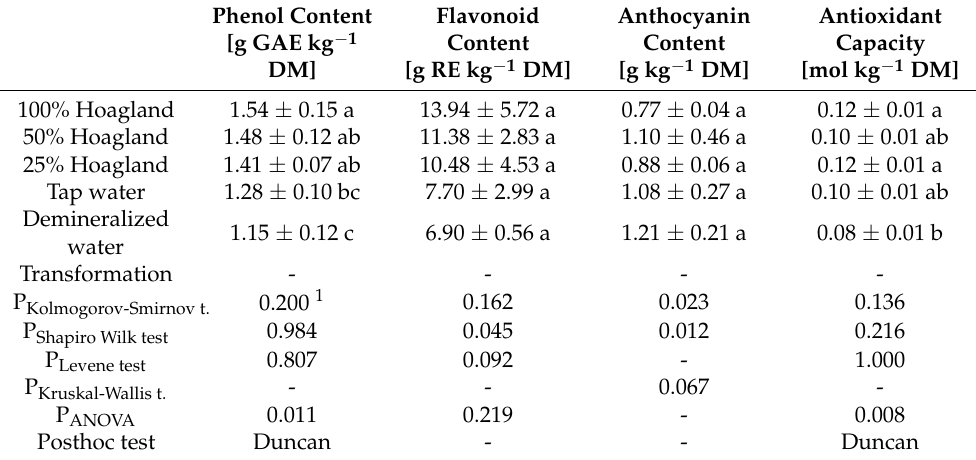
Table 10. Content of phenolic compounds and antioxidant capacity in the cotyledons of radish cress in g kg − 1 dry mass (DM) and mol kg − 1 DM, respectively. Different letters within a column indicate significant